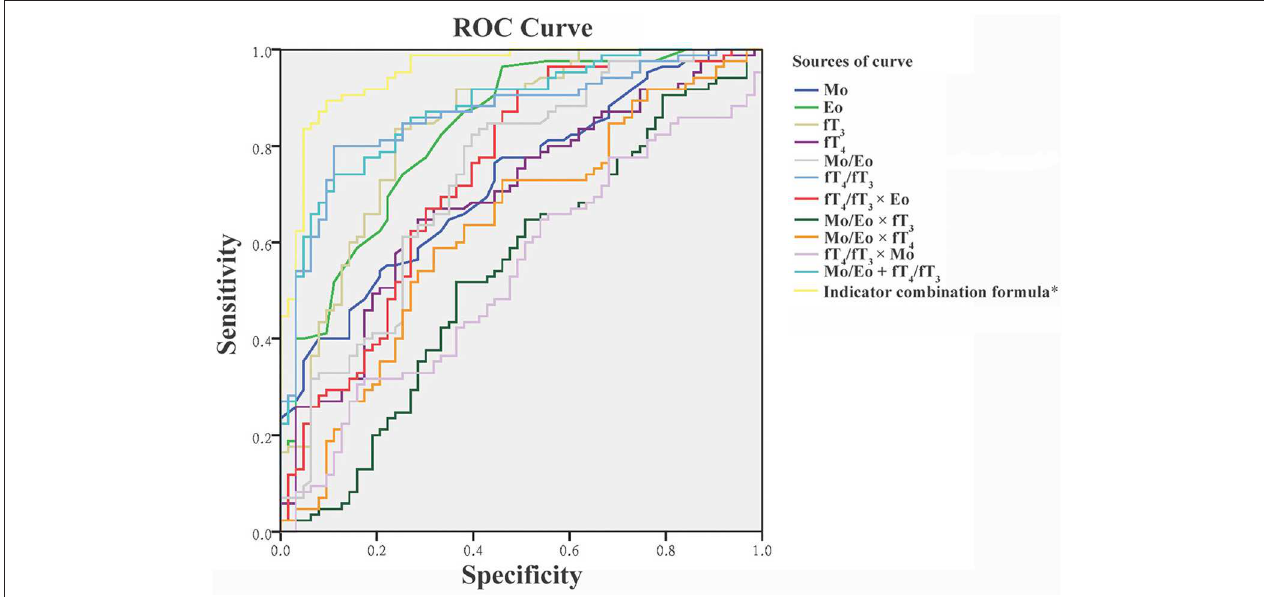
FIGURE 1 | Receiver operating characteristic (ROC) curve for the discrimination of patients with Graves’ disease from healthy controls and patients with subacute thyroiditis. *The detailed indicator combination formula is presented in the text. Eo, eosinophils; fT 3 , free triiodothyronine; fT 4 , free thyroxine; Mo, monocytes.